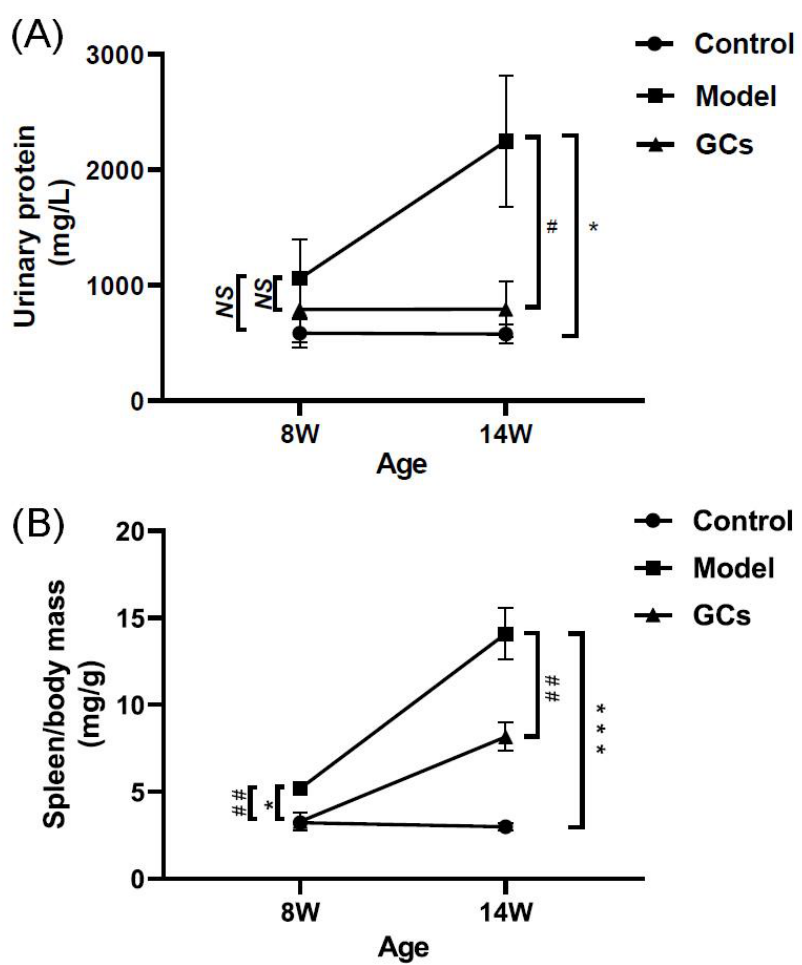
Figure 2. Comparison of the manifestations of MRL/lpr mice from each group at different states. Fresh urine samples and spleen tissues of the control ( n = 4), model ( n = 4), and GCs ( n = 4) groups were collected at 8 and 14 weeks of age, respectively. Both model and GCs group were MRL/lpr mice, while the control group was MRL/MpJ mice. ( A ) Urinary protein levels. ( B ) The ratio of spleen-to-mouse body weight. The data represent means ± SEM from different groups. Difference between the groups was determined using ANOVA followed by Dunn multiple comparison with IBM SPSS Statistics 19 Software (SPSS Inc., Chicago, IL, USA) after the normality of each group of variables was checked by Q–Q plots. The raw p values were adjusted to false discovery rat using the Benjamini–Hochberg method.* adjusted p < 0.05 and *** adjusted p < 0.001 compared with those in the control group. # adjusted p < 0.05 and ## adjusted p < 0.01 compared with those in the model group. NS , not significant.